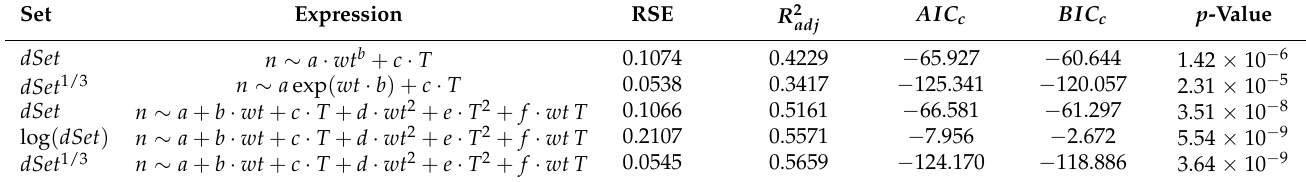
Table 13. Regression results for n as a function of wt and T for the XG dataset.